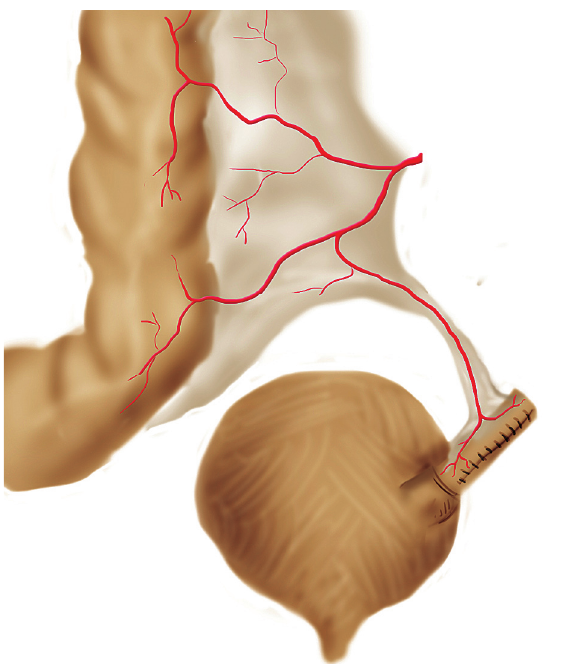
Figure 2 – Anastomosis of newly build tube on the superior part of the postero-lateral junction of the